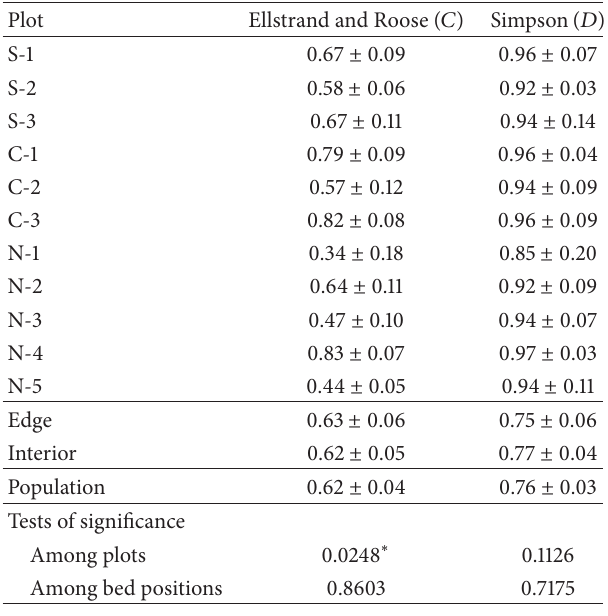
Table 2: Mean values ± standard errors of genetic diversity indices; by plot, bed position, and the entire population; 𝑃 values from tests of significance of genetic diversity. Significance at the level of 𝛼 = 0.05 is indicated by “ ∗